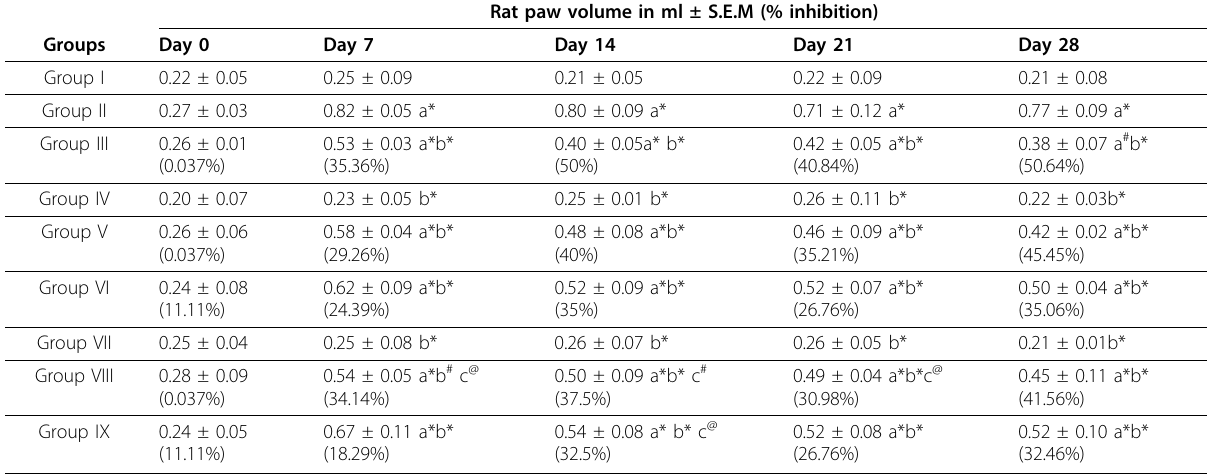
Table 1 Effect of SPP and SPE on rat paw edema in Freund ’ s adjuvant induced arthritic rats Rat paw volume in ml ± S.E.M (% inhibition)